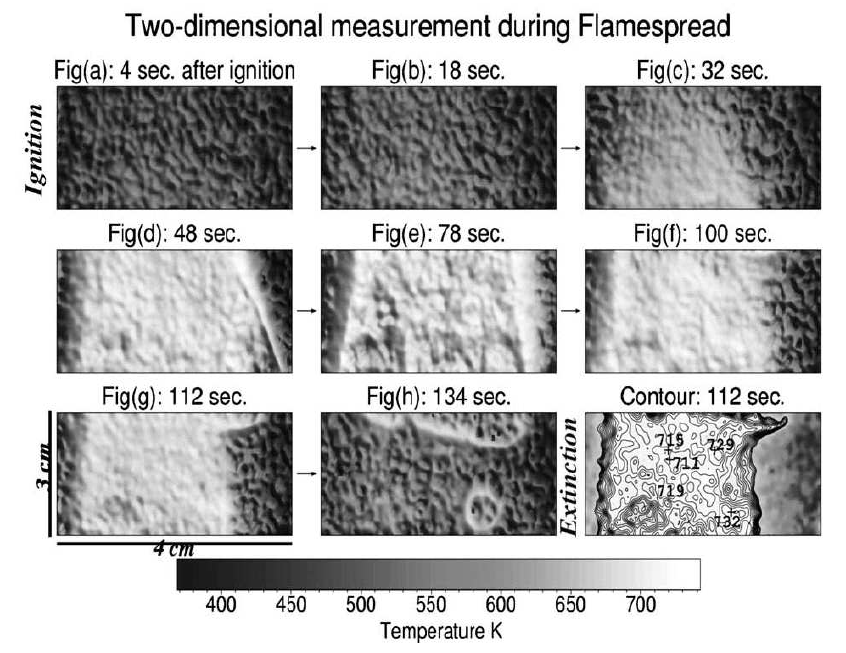
Figure 50 . Temperature measurements during flame spread. measurement of low density fibreboard (LDF)